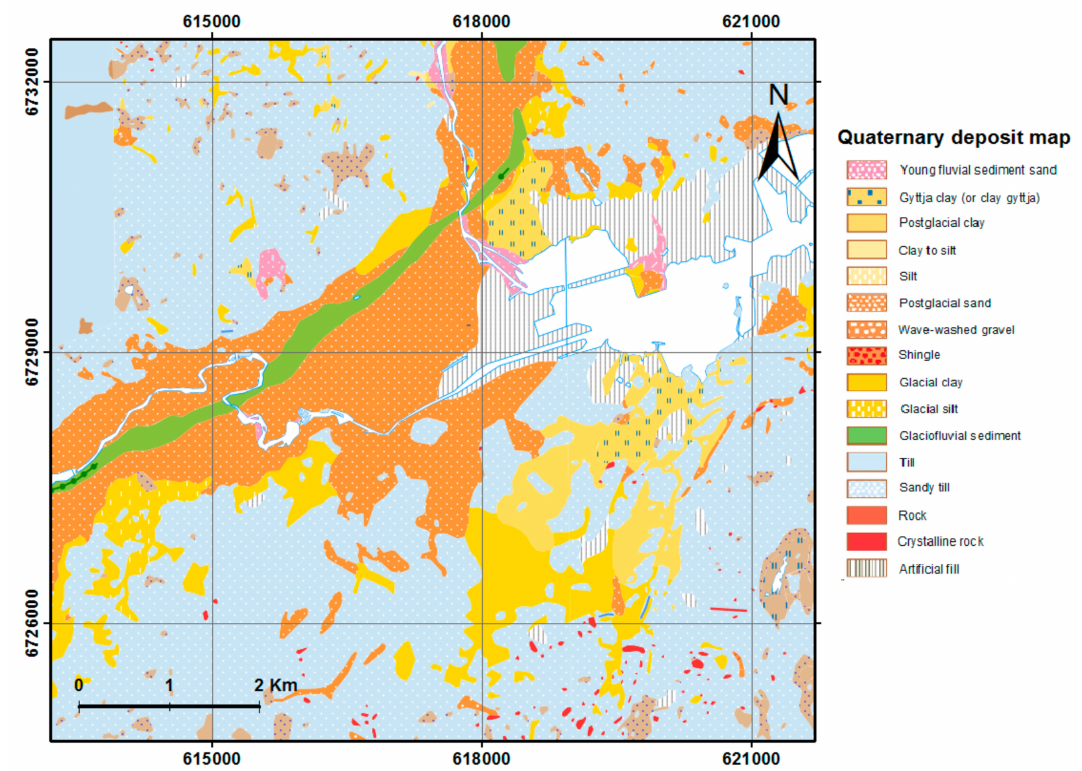
Figure 2. The quaternary deposit map of the study area © Geological Survey of Sweden (SGU). Coordinate system: SWEREF 99